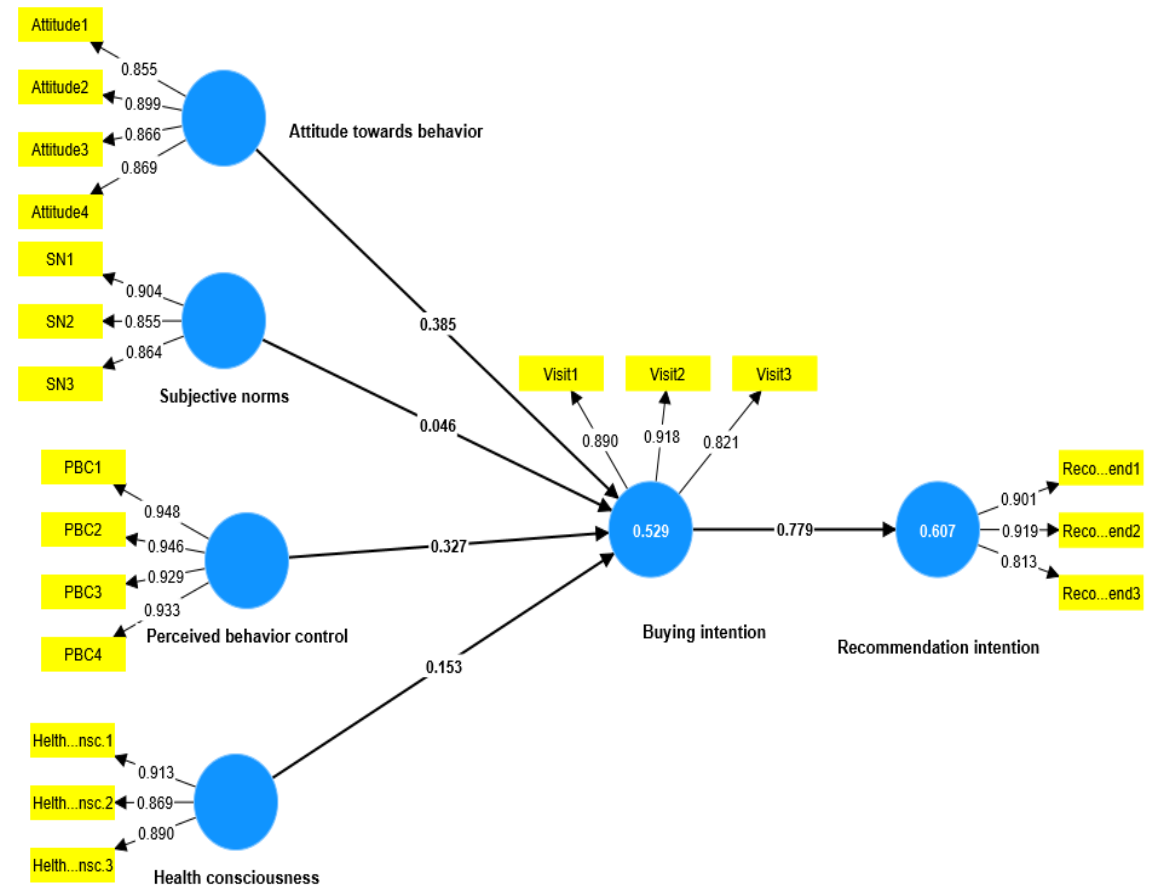
Figure 3. UK research model.